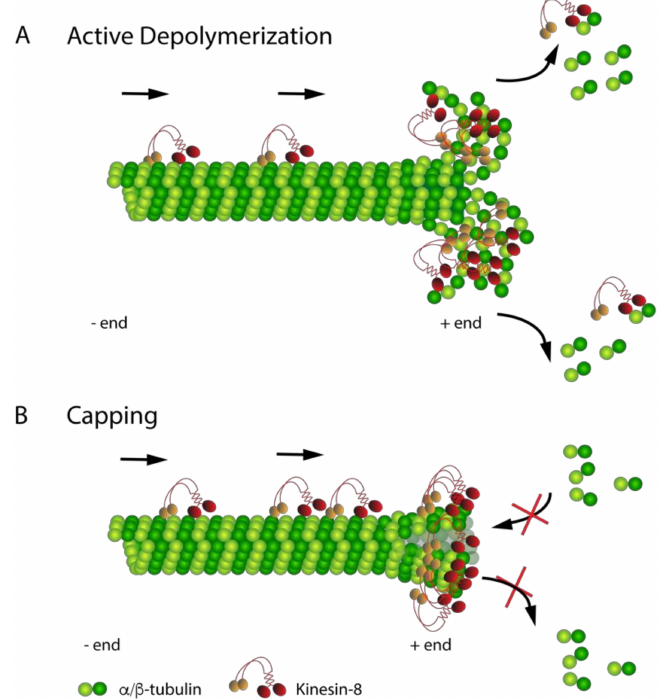
Figure 1. Proposed models for Kinesin-8 MT) depolymerization: ( A ) The active depolymerization model proposes that the Kinesin-8 motor protein walks on the MT lattice towards the plus end where it dwells for some time before depolymerizing the MT. ( B ) The capping model proposes that the Kinesin-8 protein, particularly human Kif18A, suppresses MT dynamics at the plus ends by serving as a capping factor. Capping blocks both growth and shrinkage, ultimately leading to MT catastrophe and depolymerization of the MT